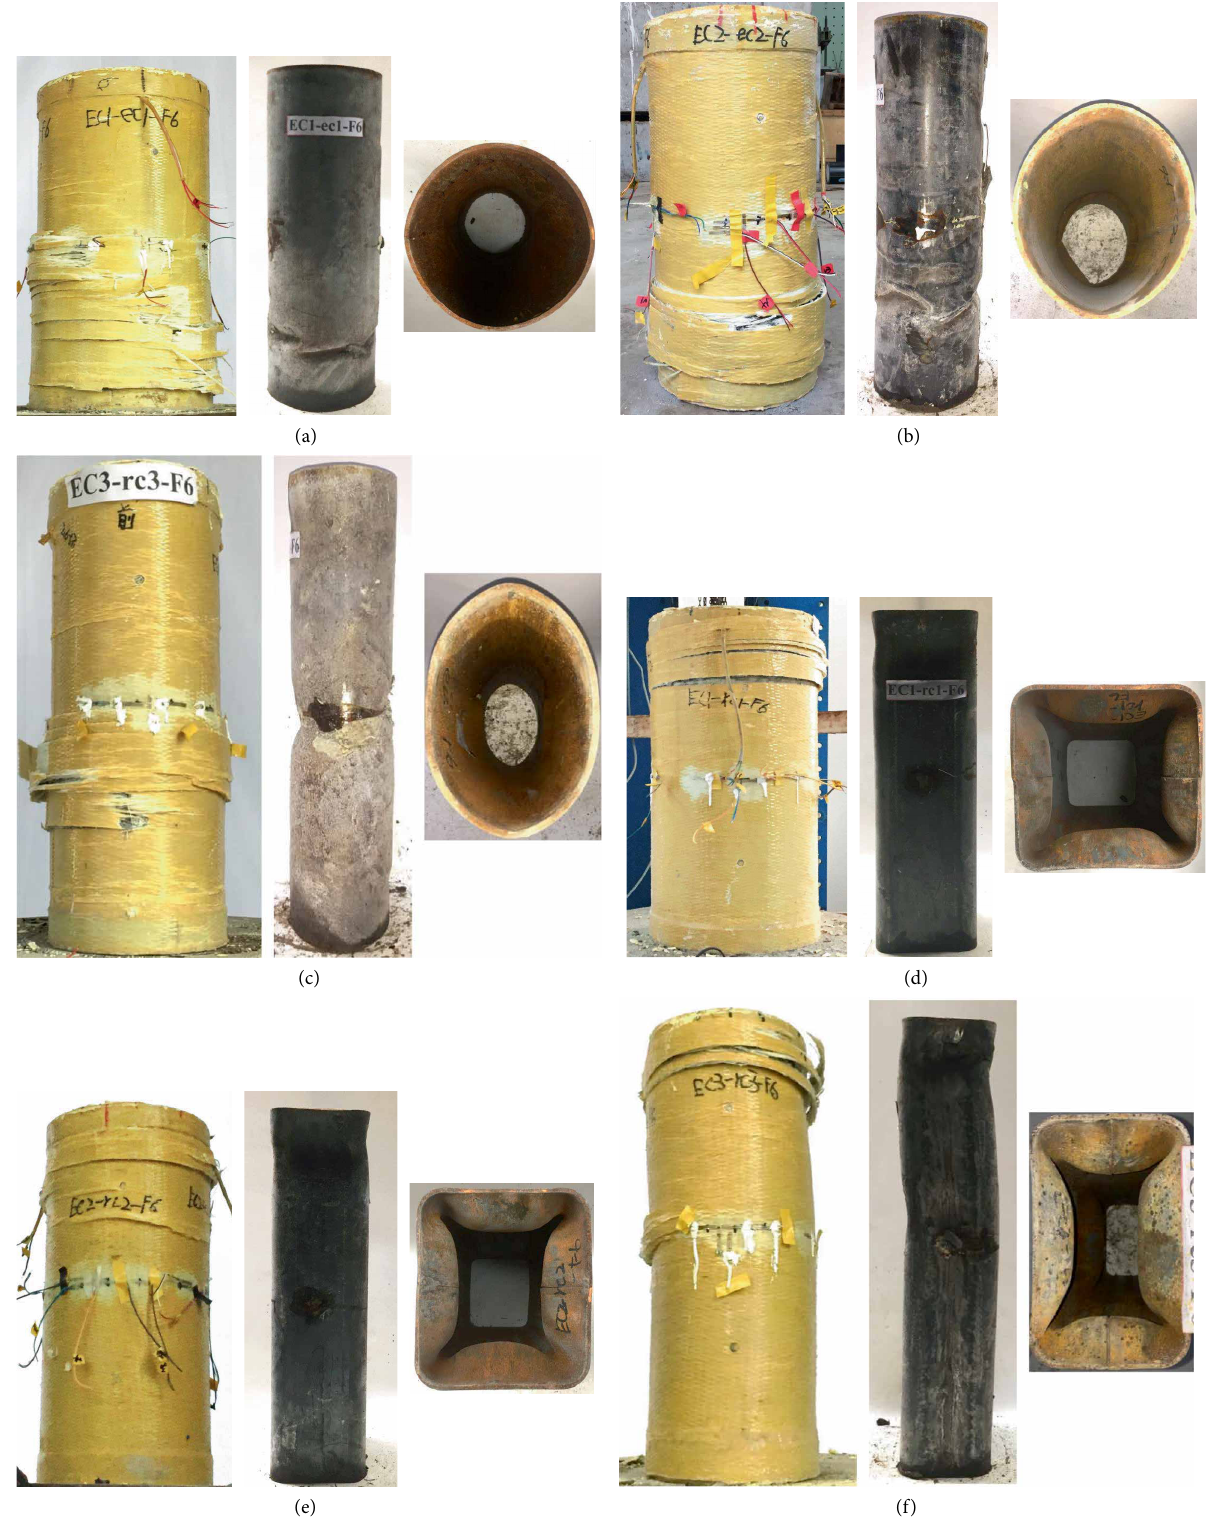
Figure 7: Typical specimens after test. (a) EC1-ec1-F6. (b) EC2-ec2-F6. (c) EC3-ec3-F6. (d) EC1-rc1-F6. (e) EC2-rc2-F6. (f)